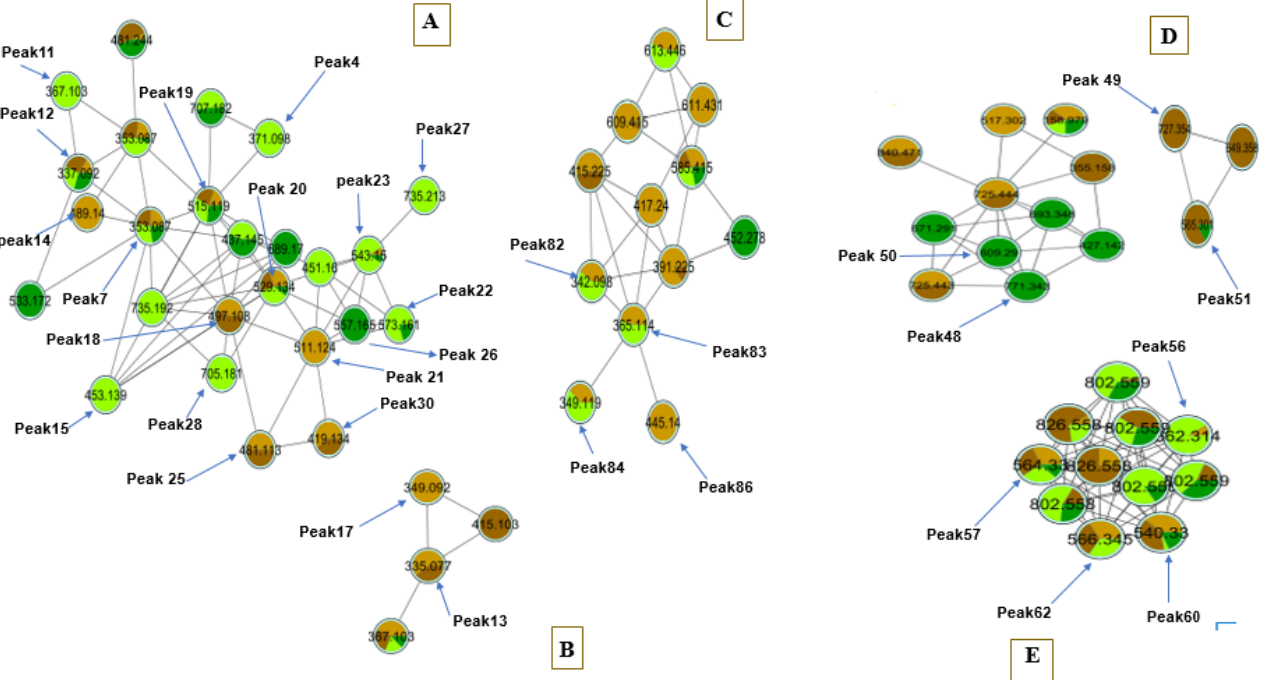
Figure 1. Molecular networks of major clusters created from authenticated coffee samples, i.e., GCA, GCC, RCA, and RCC. For all the networks, nodes are color ‐ coded based on the roasting and species present and labelled by their parent ions. Light and dark green correspond to green Coffea robusta and green C. arabica , respectively, while light and dark brown correspond to roasted C. robusta and roasted C. arabica , respectively. ( A ) Molecular network of hydroxycinnamate esters. ( B ) Hydroxycinnamic lactones. ( C ) Hydroxycinnamic amides. ( D ) Diterpenes. ( E ) Fatty acids and sphingolipids.